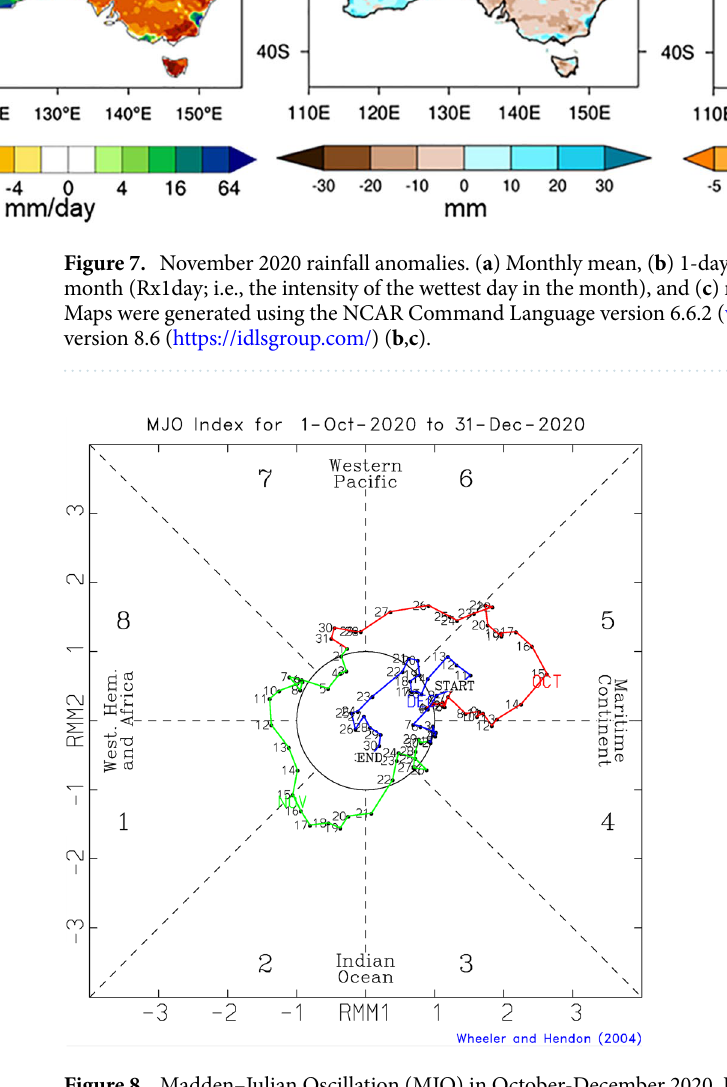
Figure 8. Madden–Julian Oscillation (MJO) in October-December 2020. Phase space of the Real-time Multivariate MJO (RMM) index of Wheeler and Hendon (2004) 40 for the period 1 October to 31 December 2020. Each dot represents a day and the sequence of days is joined by coloured lines. In October (red) the MJO was primarily in Phases 5 and 6, in November (green) it was primarily in Phases 8, 1, 2, and 3, and in December (blue) in Phase 5 and the Weak MJO